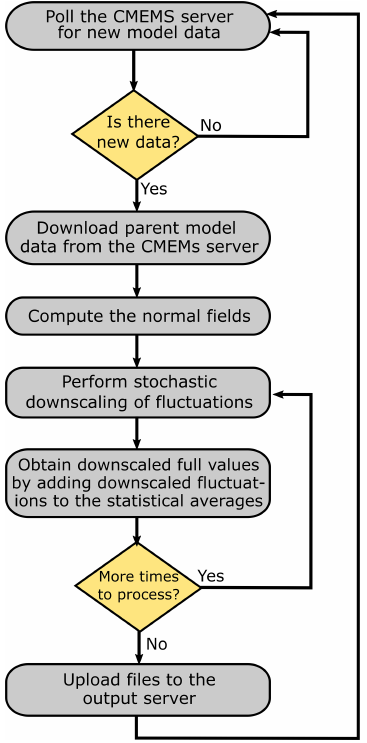
Figure 5. Flowchart showing the workflow of SMORS operational model.